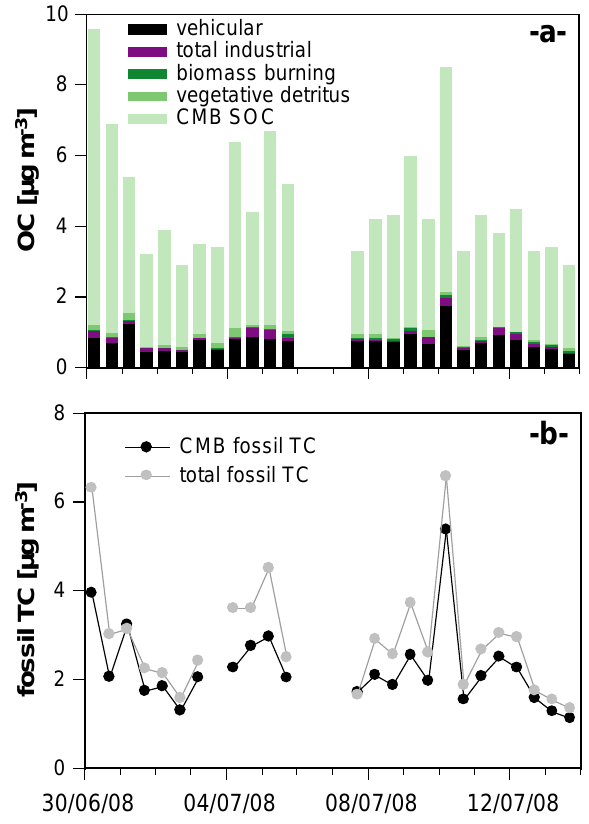
Fig. 7 Fig. 7. (a) Source contributions to ambient organic carbon (OC) de- termined by the CMB modelling. (b) Comparison of TC fossil frac- tions resolved by 14 C and CMB modelling (sum of TC (OC+EC) emitted from mobile sources and industrial